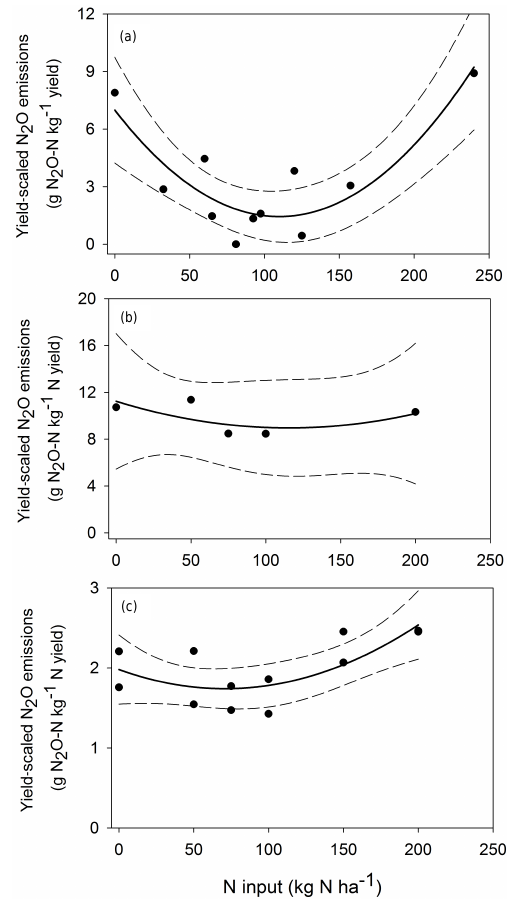
Figure 4. Relationship between nitrogen (N) input and yield scaled nitrous oxide (N 2 O) emissions. Grain type: (a) rape ( Brassica na- pus ) and (b, c) maize ( Zea mays L.). Data sources: (a) from Nya- madzawo et al. (2014a), (b) from Hickman et al. (2014) and (c) from Hickman et al. (2015). The dashed lines indicate 95% confidence intervals. Note the different scales across